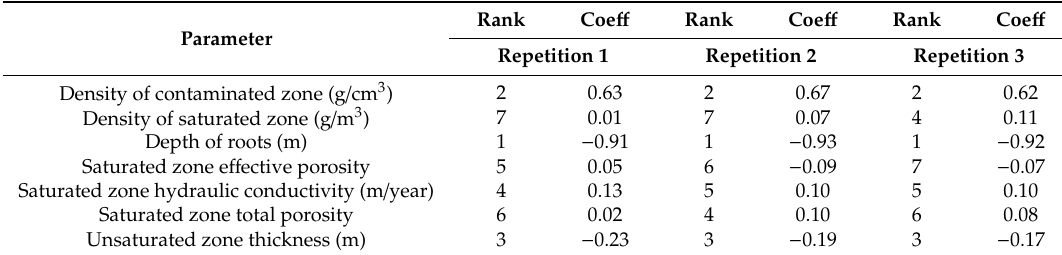
Table 5. PRCC value of each parameter.